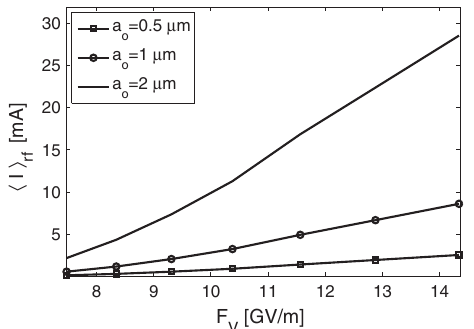
FIG. 10. The rf averaged current versus the enhanced vacuum electric field F V for various values of scaling factor a o